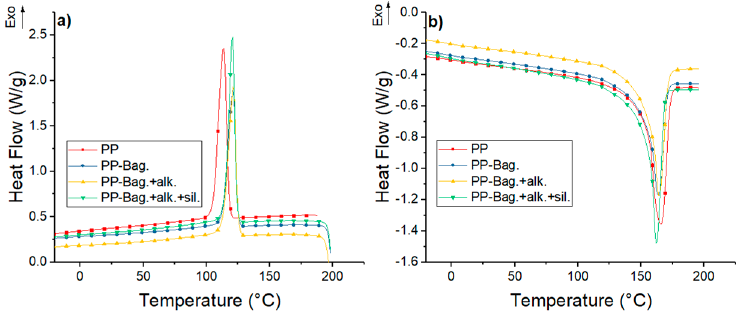
Figure 6. ( a ) Cooling and ( b ) second heating DSC curves for fifth processing cycle PP and PP-Bagasse biocomposites. Table 3. Thermal properties on cooling and second heating di ff erential scanning calorimetry (DSC) scans of the